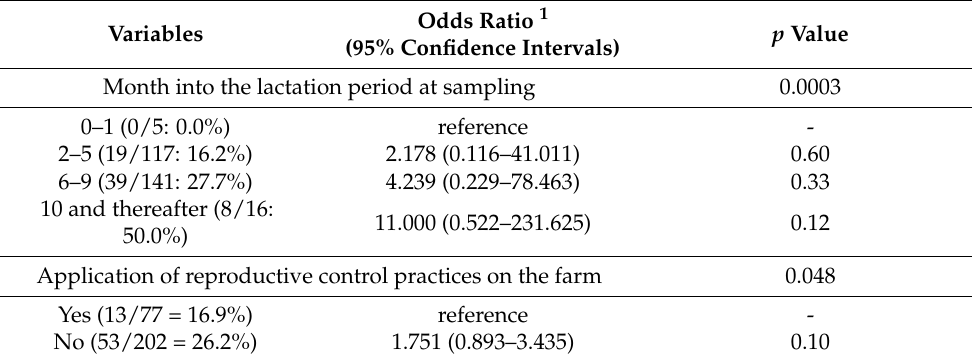
Table 4. The results of the multivariable analysis for high (>300) epg counts in faecal samples from 279 sheep flocks in a countrywide investigation in Greece.